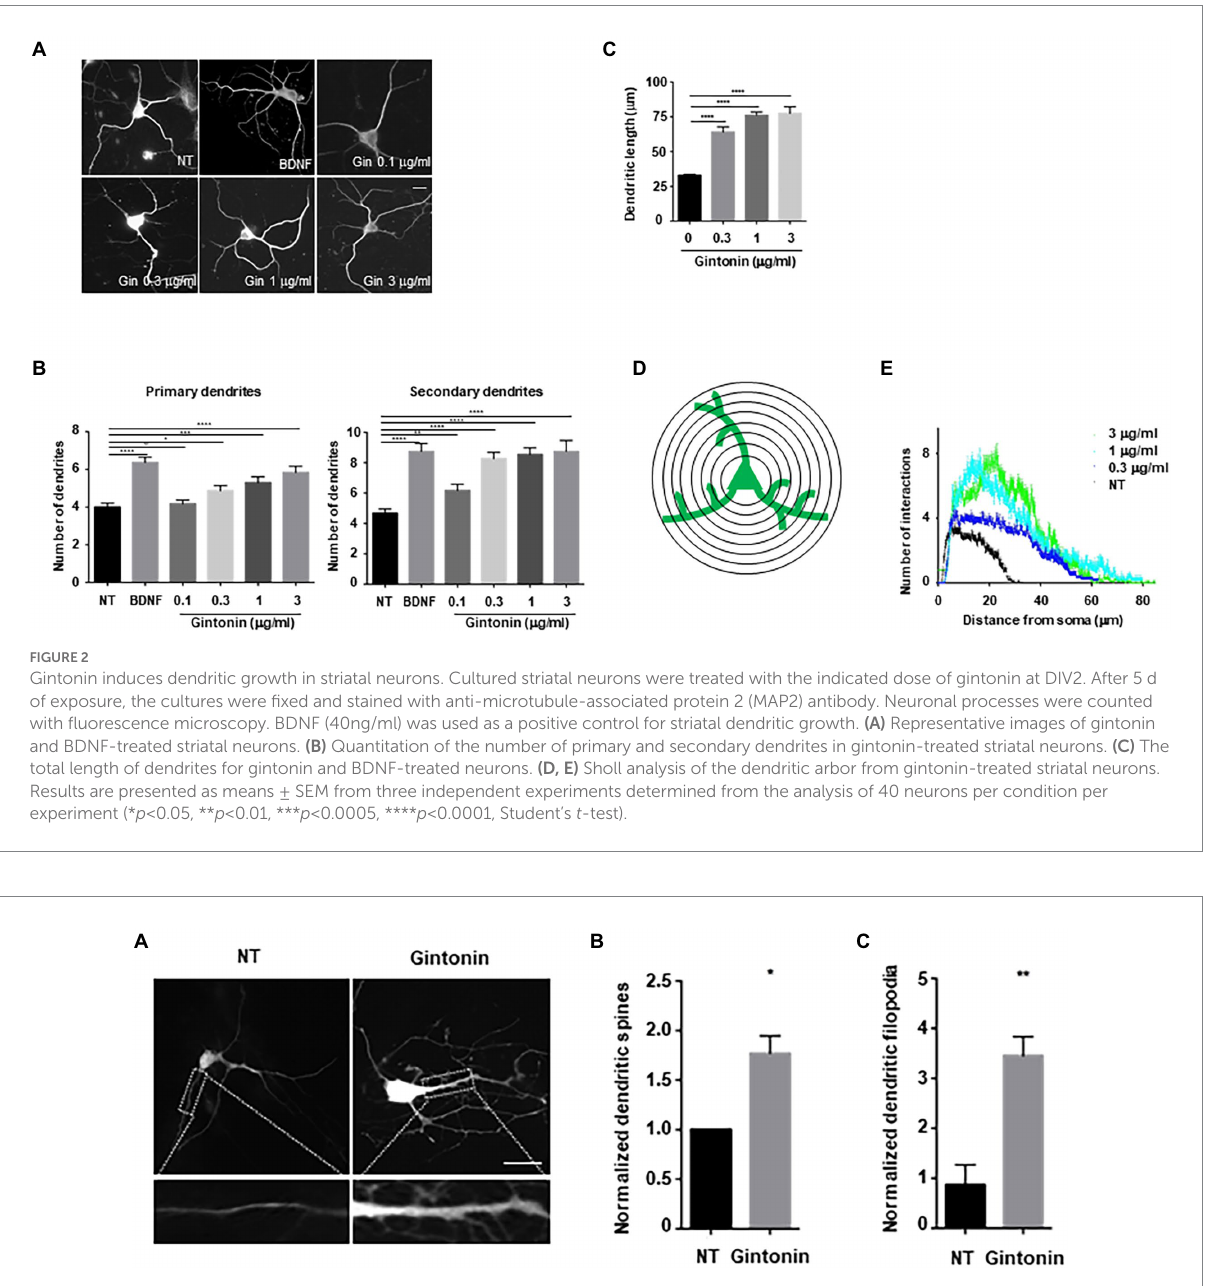
FIGURE 3 Gintonin increases filopodia-type dendritic spine density. (A) Representative images showing dendritic spine formation upon gintonin treatment in striatal neurons. DIV9 striatal neurons were treated with 3 μ g/ml of gintonin for 5 days, until DIV14. Striatal neurons were transfected with GFP vector at DIV12 to visualize dendritic spines. Neurons were fixed at DIV14, and spines were counted in maximum-intensity projections of the z-stacks using ImageJ software. Scale bar, 2 μ m Quantification of total (B) and filopodia-type spines (C) . Results are presented as means ± SEM from three independent experiments determined from the analysis of 40 neurons per condition per experiment (* p < 0.05, ** p < 0.01, Student’s t